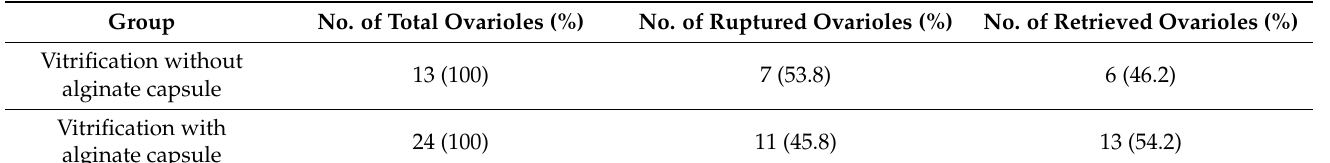
Table 1. Comparison of the ovarioles’ viability between vitrification without or with an alginate cap- sule.